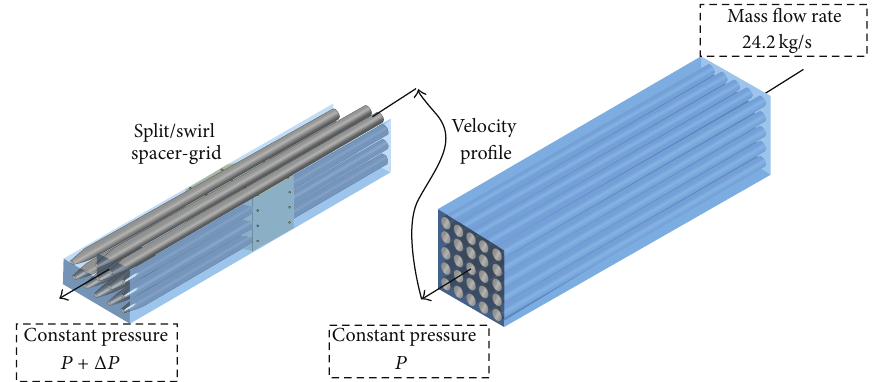
Figure 4: Inlet and outlet boundary conditions for the bare rod bundle and the model with the spacer-grid.